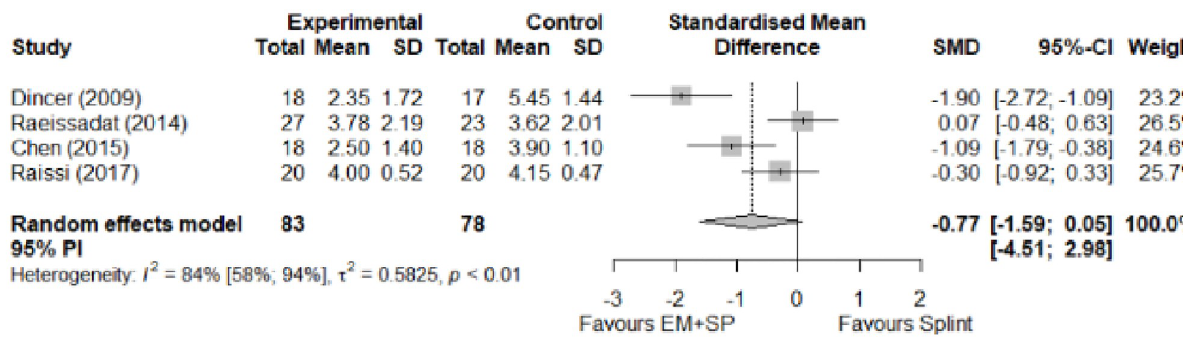
Fig 27. Analysis—Electrophysical modalities plus splint versus splinting (pain).